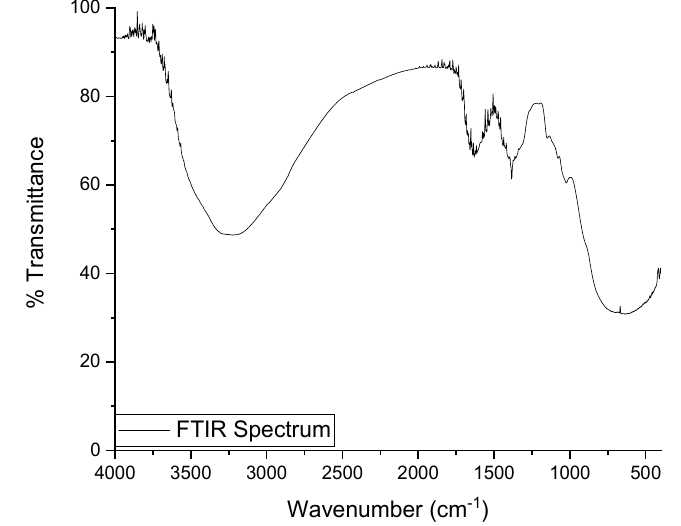
Figure 3. FTIR spectrum of SnO 2